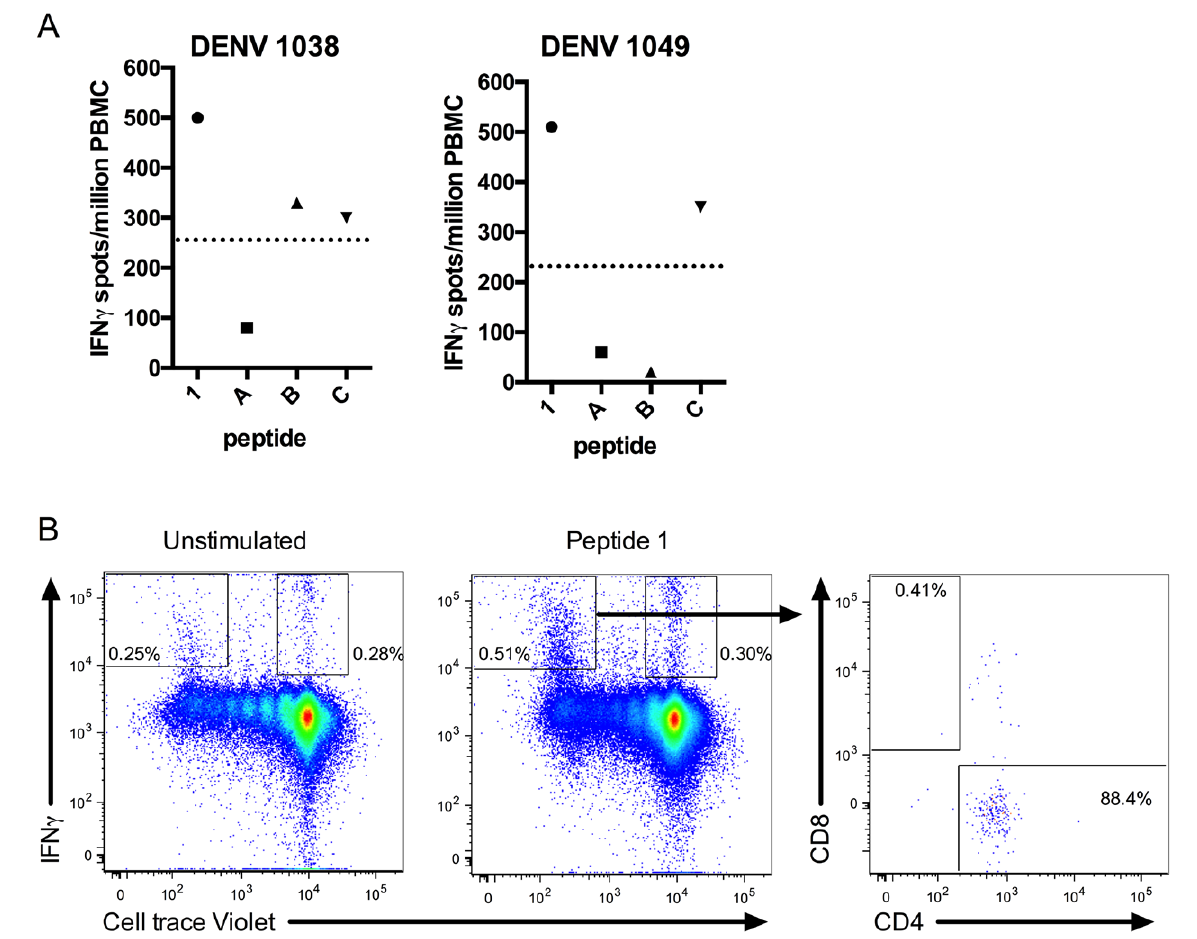
Figure 4. Fine Mapping of Peptide 1. IFN γ spots per million PBMCs after stimulation with peptides 1, A, B, and C for DENV 1038 and 1049. The dashed line represents the background level of IFN γ in the absence of stimulation multiplied by 2 (A). CellTrace Violet labeled PBMCs were stimulated for 6 days with pep- tide 1 in the presence of IL-2 (20 U/ml) before re-stimulation with peptide 1 for 12 hours in the presence of monensin. As a negative control, PBMCs were cultured with IL-2 in absence of peptide stimulation. Cells were then stained for CD3, CD4, CD8, and IFNγ. Representative flow plots